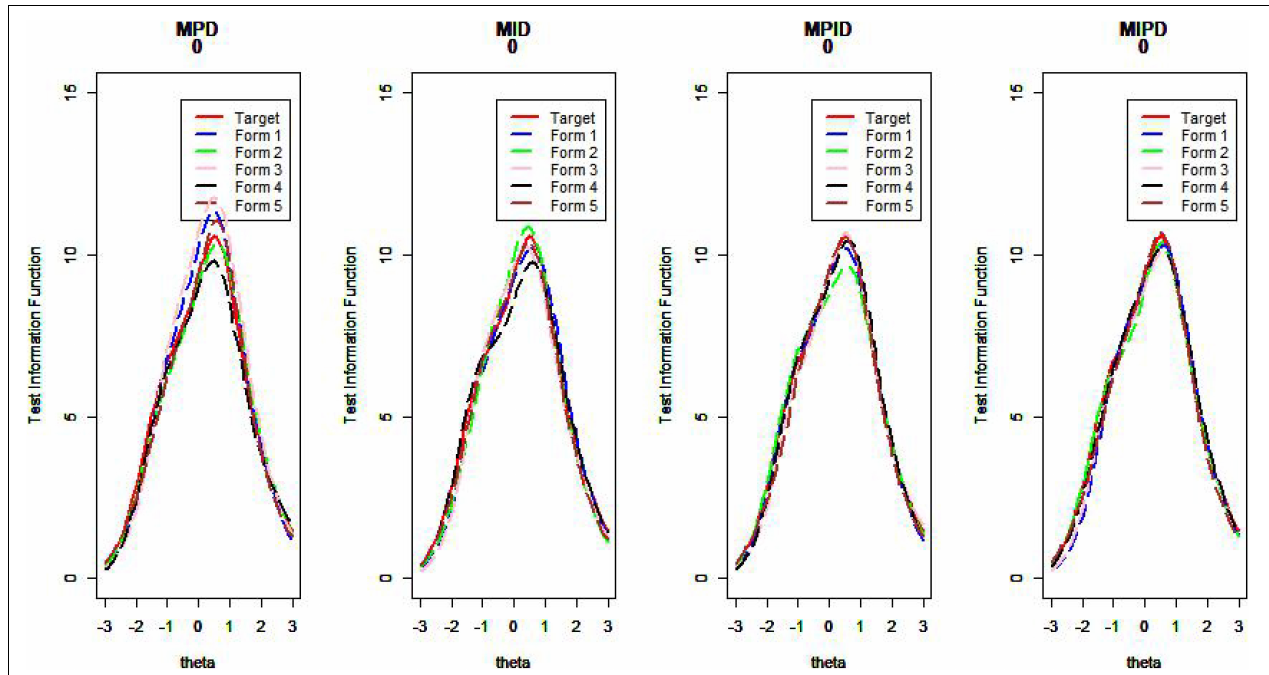
FIGURE 10 | Test information curve ( D = 0).